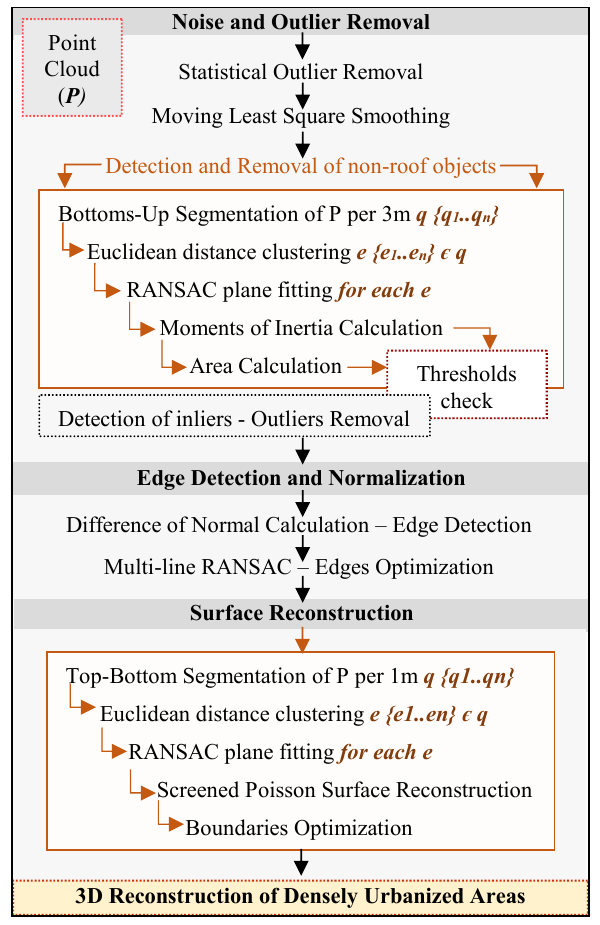
Figure 1. Workflow of the proposed